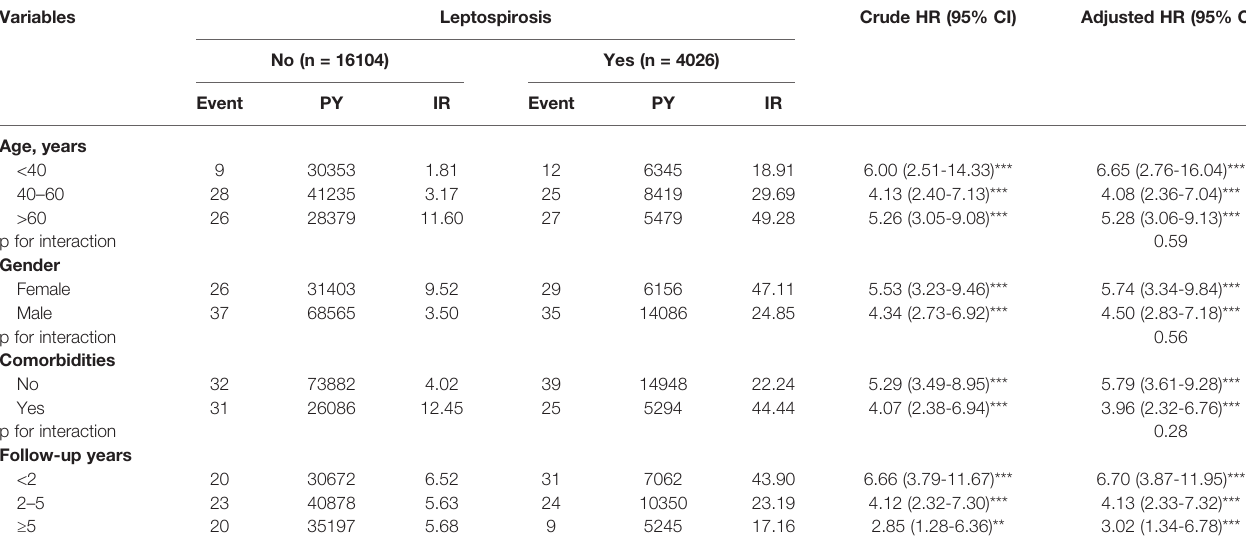
TABLE 3 | The incidence and HRs for risk of overall ADs in patients with and without leptospirosis strati fi ed by age, gender, and comorbidities.